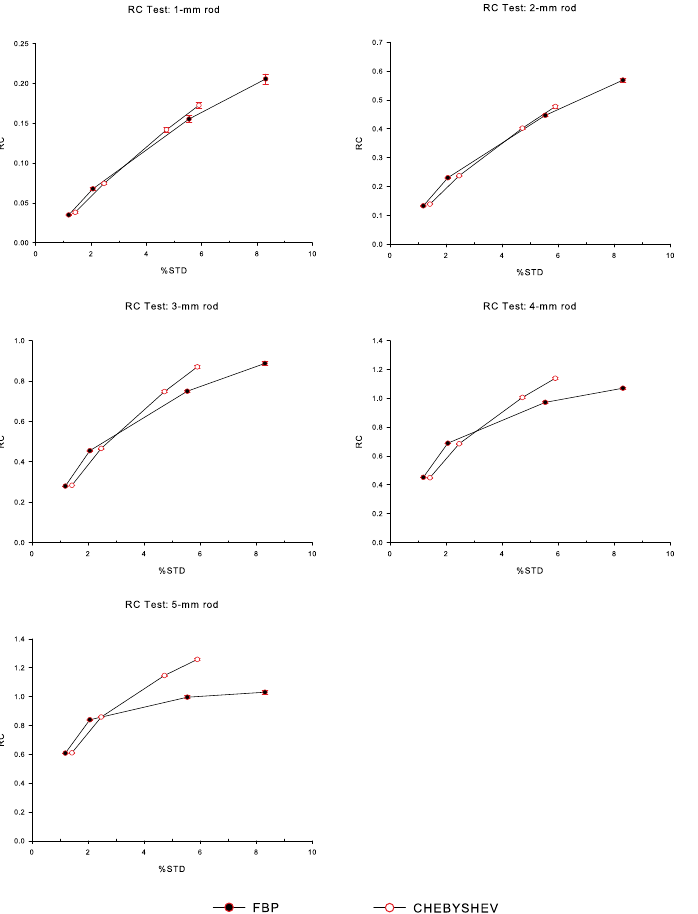
Figure 7. Recovery coefficient ( RC ) measurements for each of the hot fillable rods (diameters 1 to 5 mm) of the simulated IQ phantom, as functions of percentage standard deviation (% STD ), for Chebyshev and FBP reconstructions, corresponding to all sigma values, namely from right to left: NL3 (no smoothing), 0.5 × , 1 × , and 1.5 × sigma, respectively.